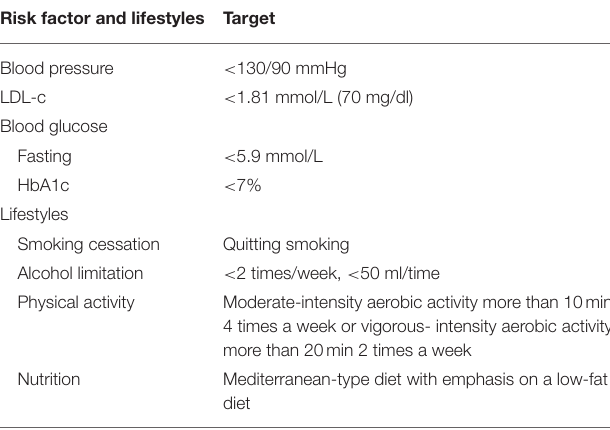
TABLE 2 | The management of vascular risk factors and lifestyles. Risk factor and lifestyles Target